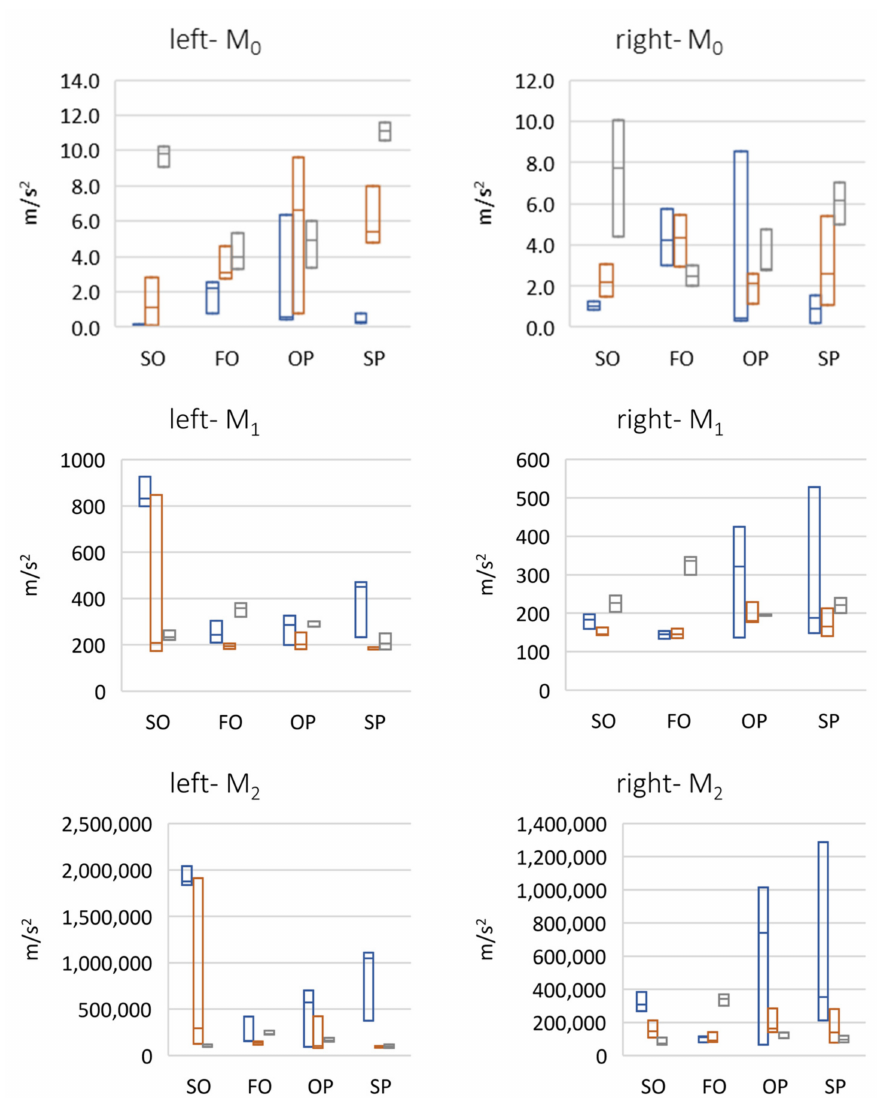
Figure 8. Frequency domain results of vibration signals (left and right side)—spectral moments (max-median-min). SO (slow opening), FO (fast opening), OP (opening with protruding), SP (slow protruding).